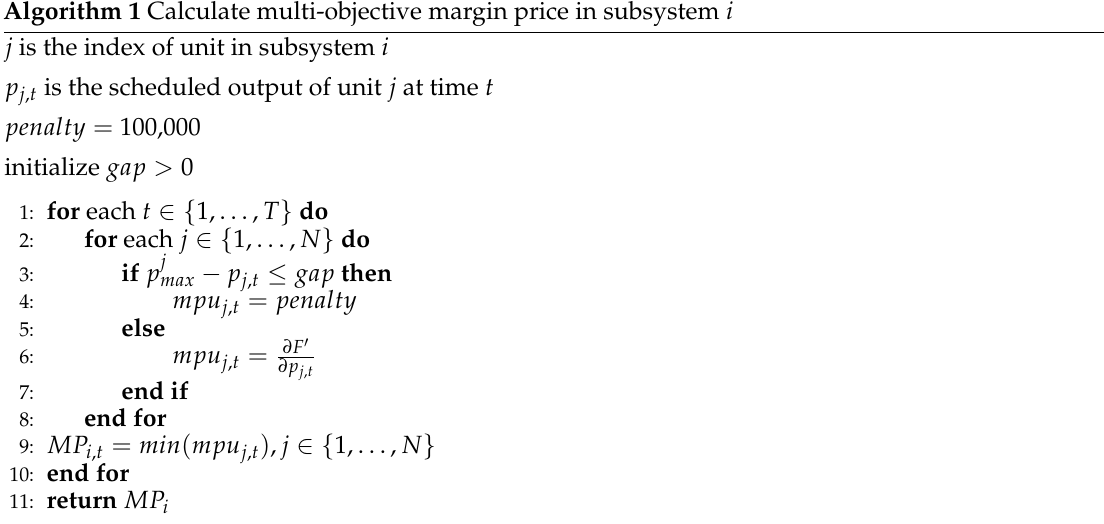
Algorithm 1 Calculate multi-objective margin price in subsystem i j is the index of unit in subsystem